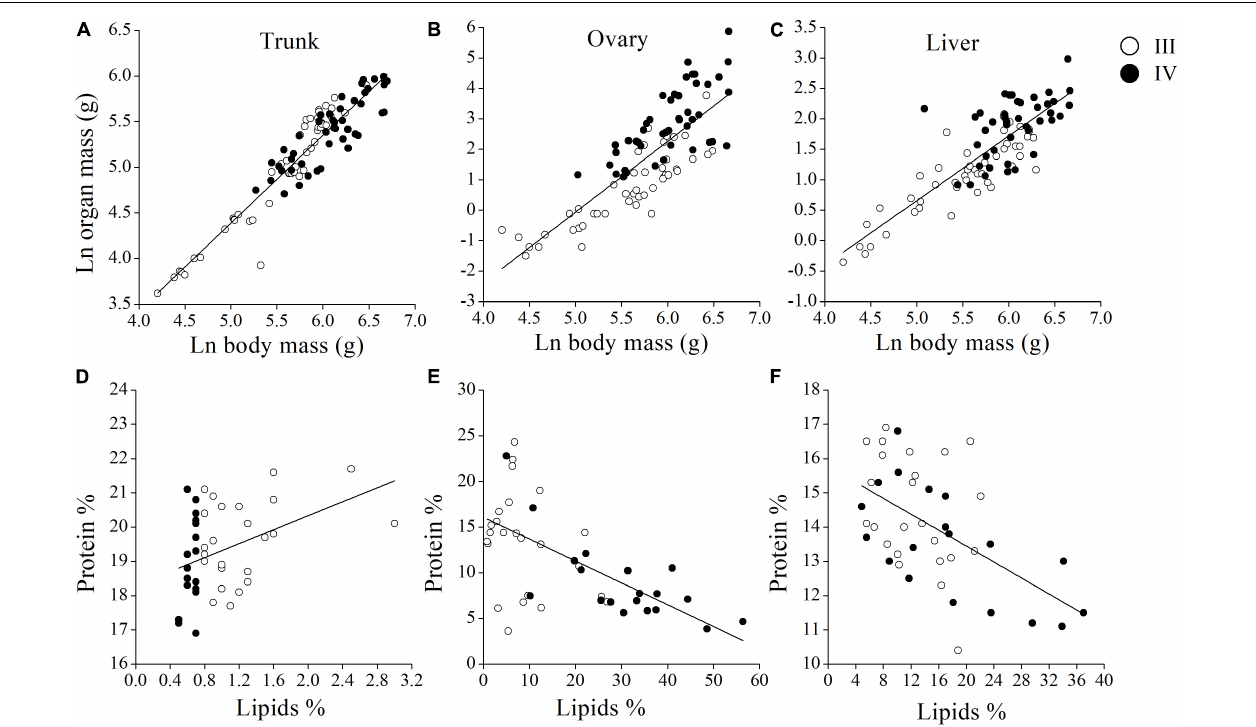
FIGURE 6 | Scatter plots indicating the relationships between the organ and body mass for maturity stage III and IV of Megalobrama terminalis female in the trunk (A) , in the ovary (B) , and in the liver (C) . Scatter plots showing the relationships between the proportion of total lipids and proteins for M. terminalis female in maturity stage III and IV in the muscle (D) , in the ovary (E) , and in the liver (F) . Lines show regression fits with the